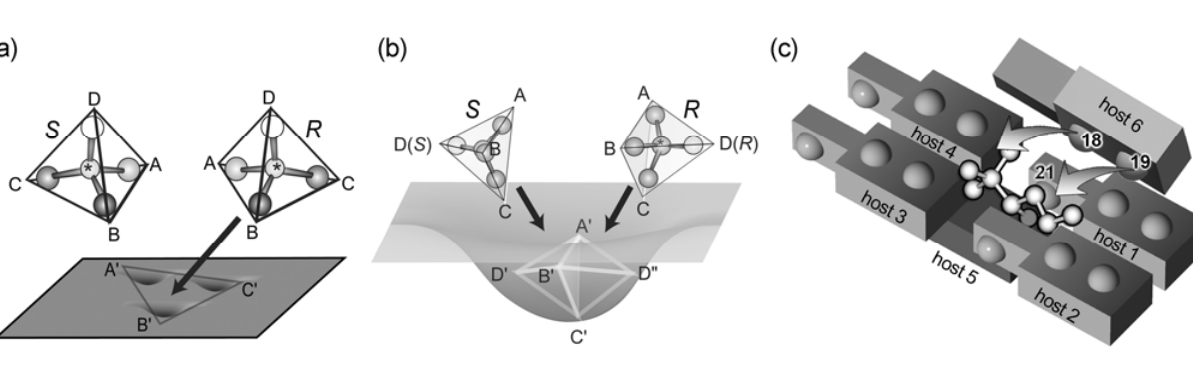
Figure 18. Models for chirality recognition. A three-location model (a) and a four- location model (b). Chirality recognition in a cage of the inclusion crystal of Ia with ( S )- 2,2-dimethyl-3-hexanol